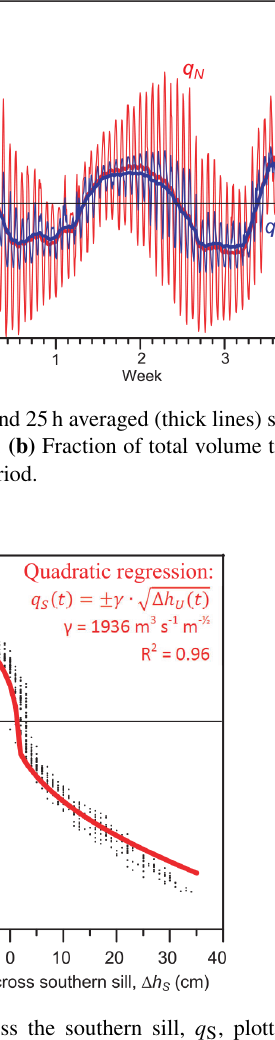
Figure 6. Volume transport across the southern sill, q S , plotted against sea level change across the southern sill, (cid:49)h S . Each black point represents 1h in the model simulation. The red curve repre- sents the result of a least squares fit to the red equation shown in the upper right-hand corner (quadratic regression). The quadratic fit (red curve and equation) explains 96% of the variance of q S